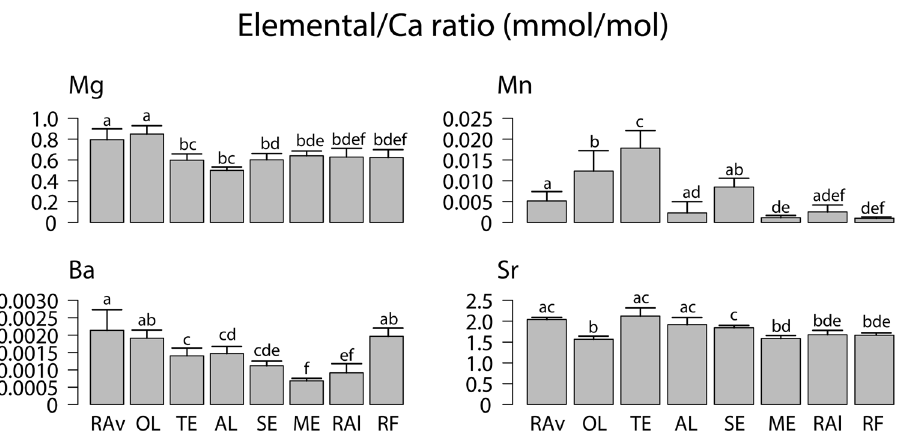
Figure 2. Ratios of trace elements to Calcium (Ca) concentrations (mmol to mol) (average ± SD; n = 10) of Cerastoderma edule shells from eight ecosystems along the Portuguese coast: Ria de Aveiro (RAv), Óbidos lagoon (OL), Tagus estuary (TE), Albufeira lagoon (AL), Sado estuary (SE), Mira estuary (ME), Ria de Alvor (RAl) and Ria Formosa (RF). Different letters on different ecosystems represent the existence of significant differences for each trace element ratio ( p <